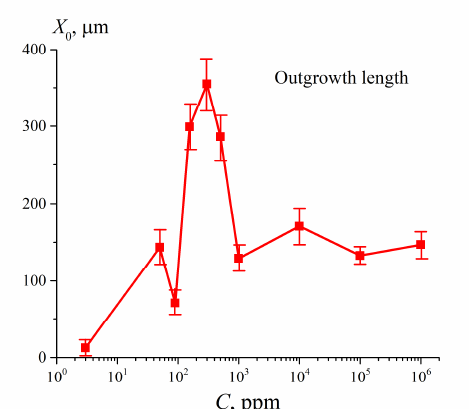
Figure 1. The size, X 0 , of the area, occupied with unwound polymer strands, vs. deuterium content of the liquid sample. See Reference [24] for more detail.